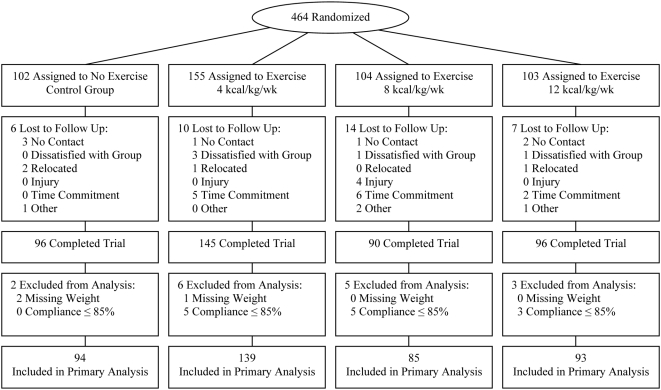
Participant flow diagram.